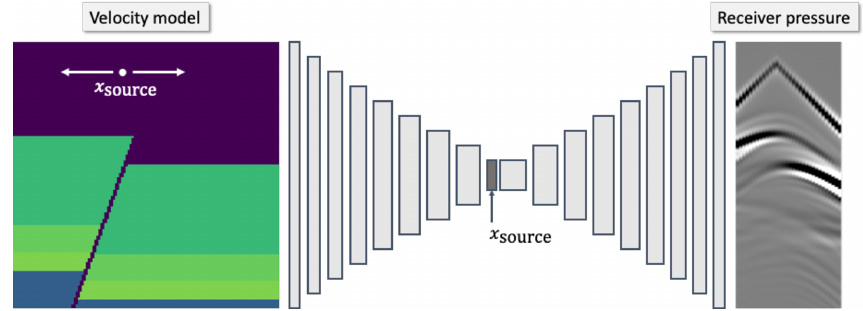
Figure 8. Our conditional autoencoder simulation workflow. Given a 2-D velocity model and source location as input, a conditional autoen- coder network outputs a simulation of the pressure responses at the receiver locations in Fig. 7. The network is composed of 24 convolutional layers and concatenates the input source location with its latent